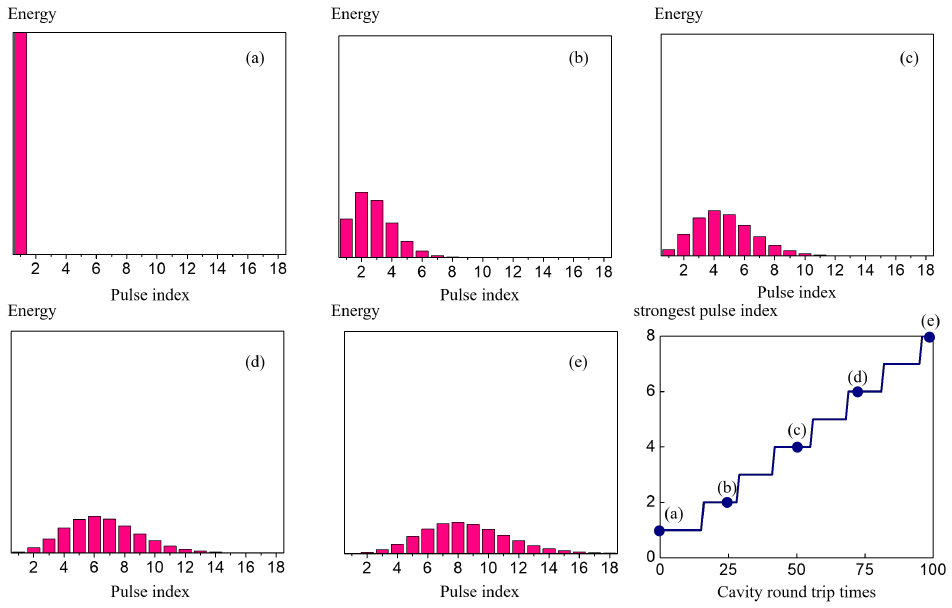
Figure 5. A single pulse starts to develop into a pulse bunch when an etalon is placed in the parent cavity. Panels ( a – e ) show the different frames of pulse bunch developing when a single pulse is propagating at ( a ) 0, ( b ) 25, ( c ) 50, ( d ) 75, and ( e ) 100 round trips in the nested cavities. A symmetric pulse bunch is formed where about 15 pulses sits under the bunch envelope. The lower right panel records the pulse position within the bunch with the highest energy along the propagation. The slope defines the envelop